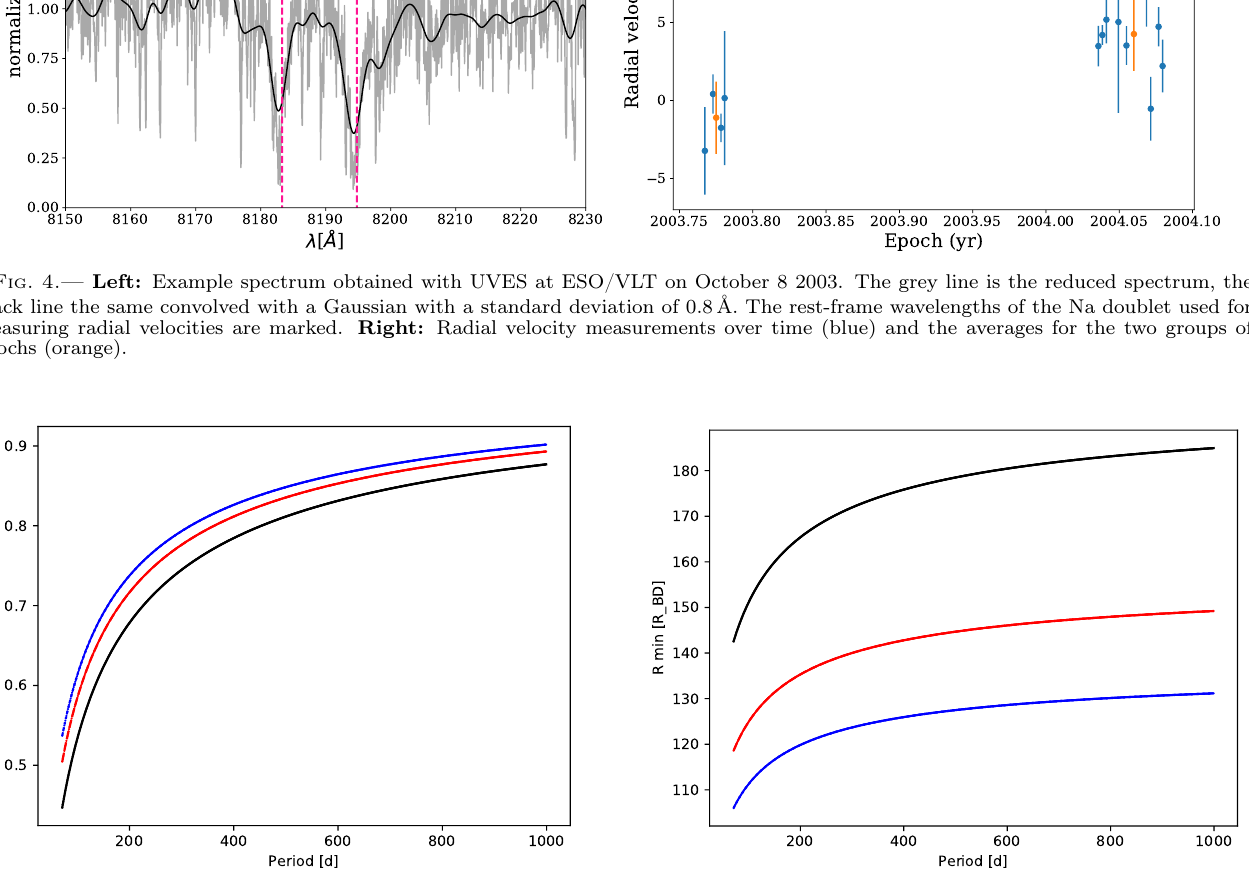
(cid:12) brown dwarf by a 0.04 (black), 0.02 (red), 0.01 M (cid:12)